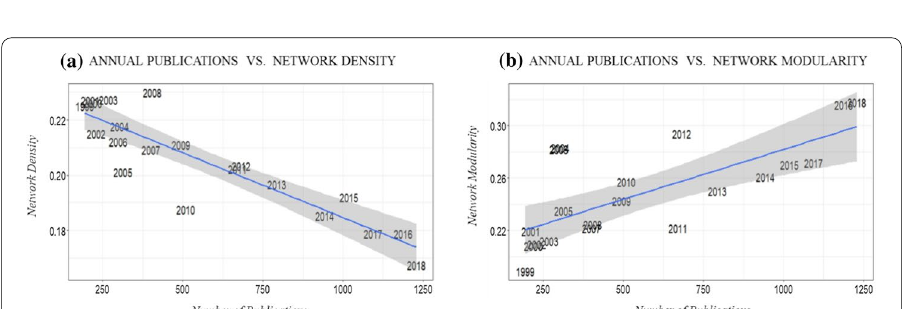
Fig. 4 Reletionship between anuual publications and network topology. This figure presents the relationship between the volume of research publications and network topology (i.e., density and modularity) for eachyear of the 20-year period. As more research articles are published over time, more densely connected subsets of topics (i.e., clustering) arepresent within the network. This demonstrates that the field is continually evolving, with new perspectives and subject areas beingemphasized by researchers on an ongoing